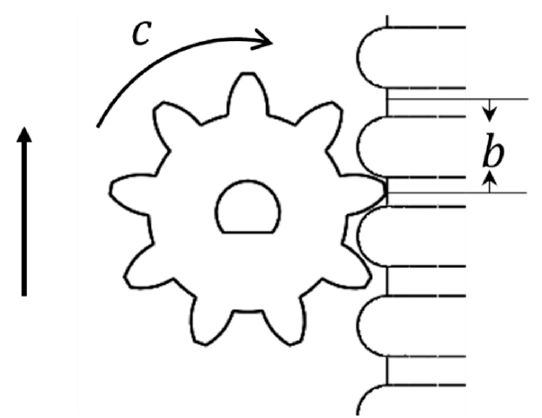
Figure 5. Modular climbing motion model.